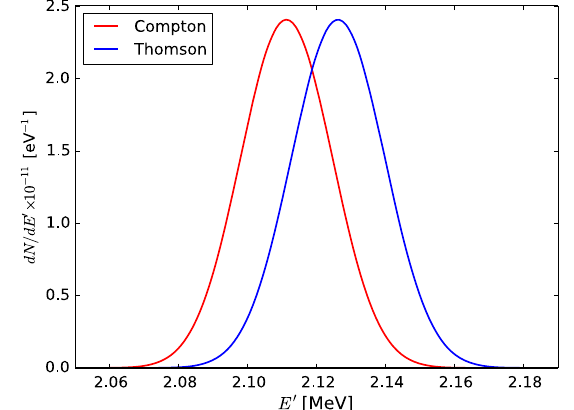
FIG. 7. Frequency shift between the spectra of Compton and Thomson scattering of a single electron with E b ¼ 300 MeV, with a laser pulse with a 0 ¼ 0 . 01 , λ ¼ 800 nm, s ¼ 20 . 3 , captured by aperture of A ¼ 1 = 10 γ .